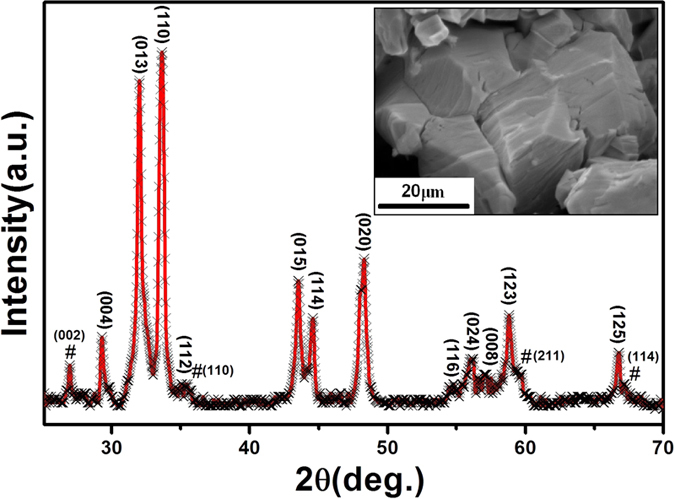
The XRD pattern of polycrystalline Sr2CoO4 sample.The inset shows the SEM image of polycrystalline Sr2CoO4 sample.